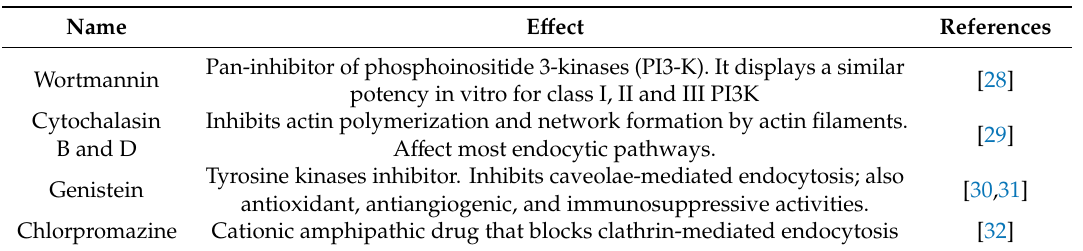
Table 1. Molecular targets and processes a ff ected by the inhibitors used to analyze the FITC-NanoMBG incorporation into DC2.4